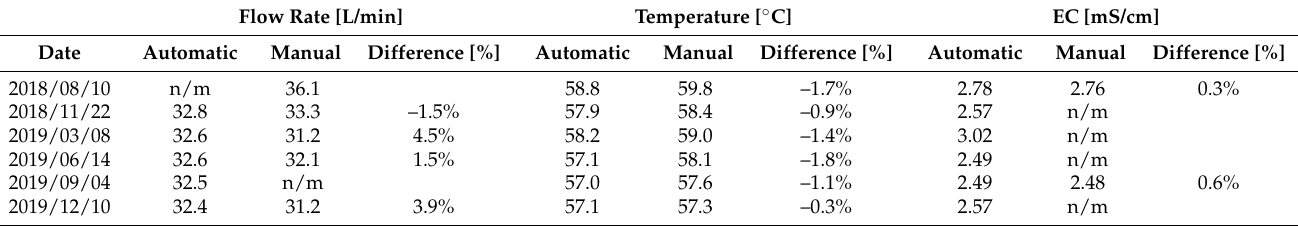
Table 2. Comparison of the automatically measured values of the hot spring monitoring device and the manually measured values of the field survey.